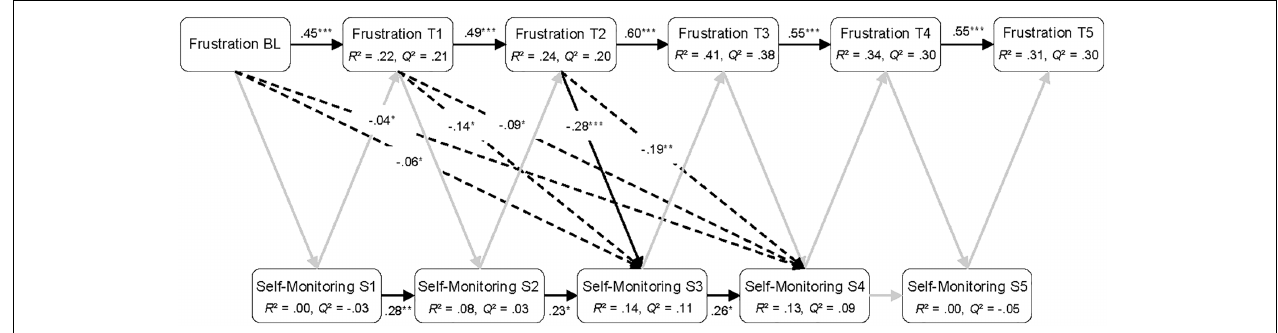
FIGURE 6 | Sequential PLS-PM analysis showing all direct and the significant indirect paths between frustration and self-monitoring. BL, baseline measurement; T1 to T5, five measurement occasions during playing Cure Runners ; S1 to S5, five sections of Cure Runners . Black lines, significant direct paths; gray lines, non-significant direct paths; dashed lines, significant indirect paths. n = 88. ∗ p < 0.05, ∗∗ p < 0.01, ∗∗∗ p < 0.001.